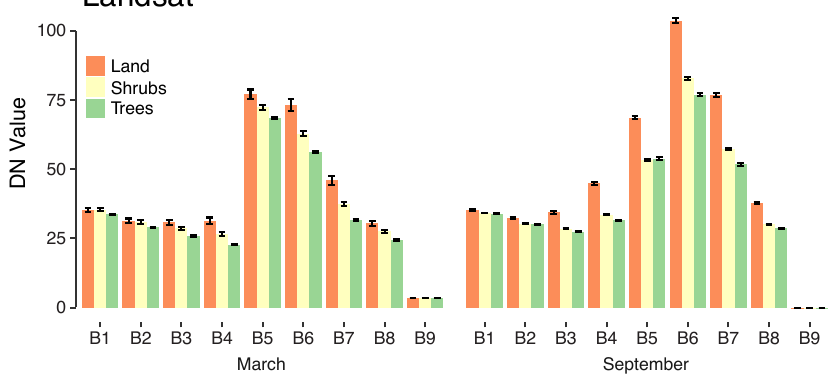
Figure 6. Spectral profile (mean values and 95% CI) of Landsat and WorldView bands, per class, in March and September (8-bit Digital Numbers (DNs)). Values are shown in table form in the Appendix B (Tables